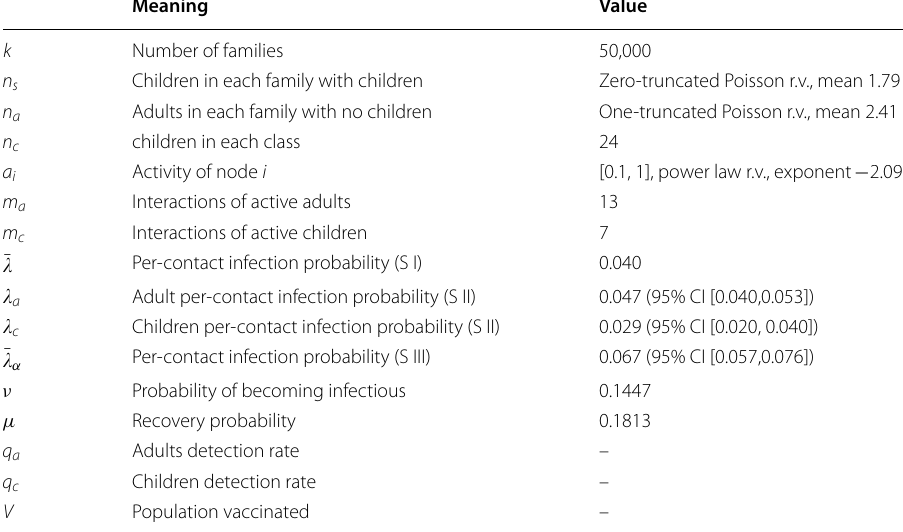
Table 2 Value of the parameters used in the simulations. The last three parameters, namely q a , q c , and V , vary across the simulations and their values are explicitly reported when presenting the